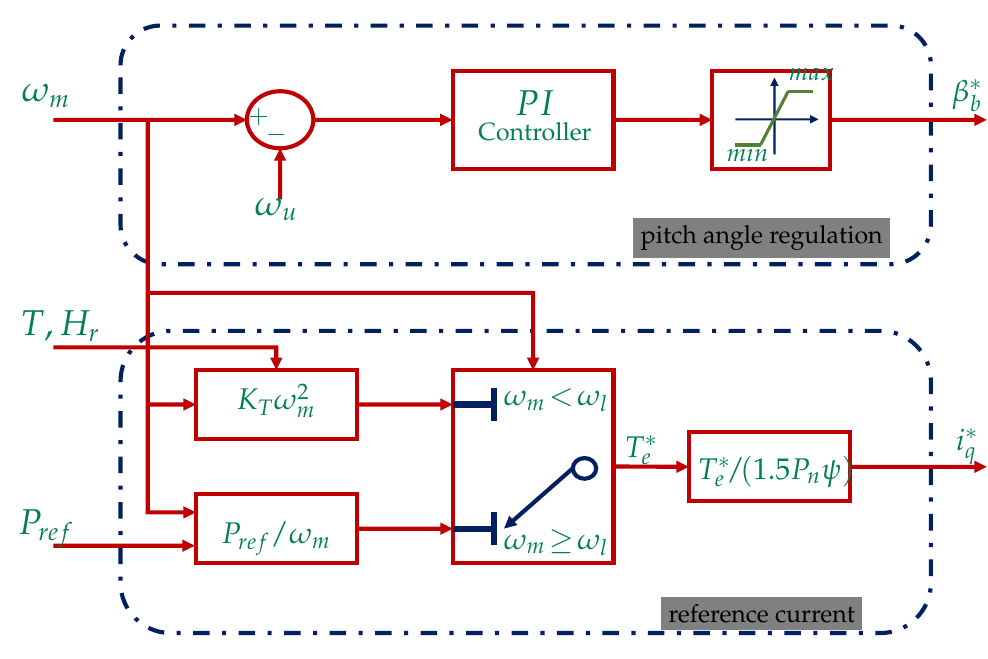
Figure 17. Active power control for reference power tracking with rotor speed control.